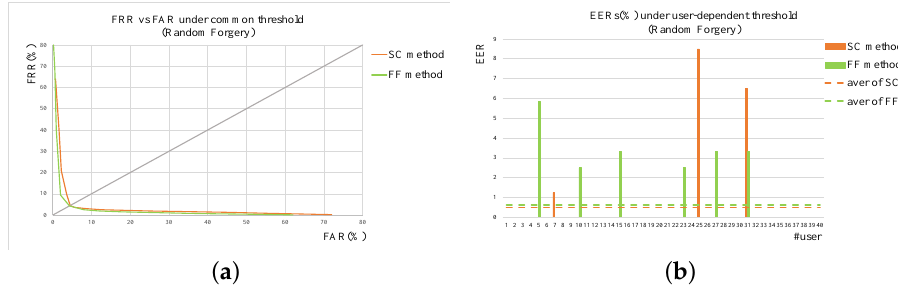
Figure 8. Results of SC and FF method on random forgery. ( a ) ROC under common threshold. ( b ) EER of each user under user threshold. In addition, those dotted lines are the average levels of corresponding methods.